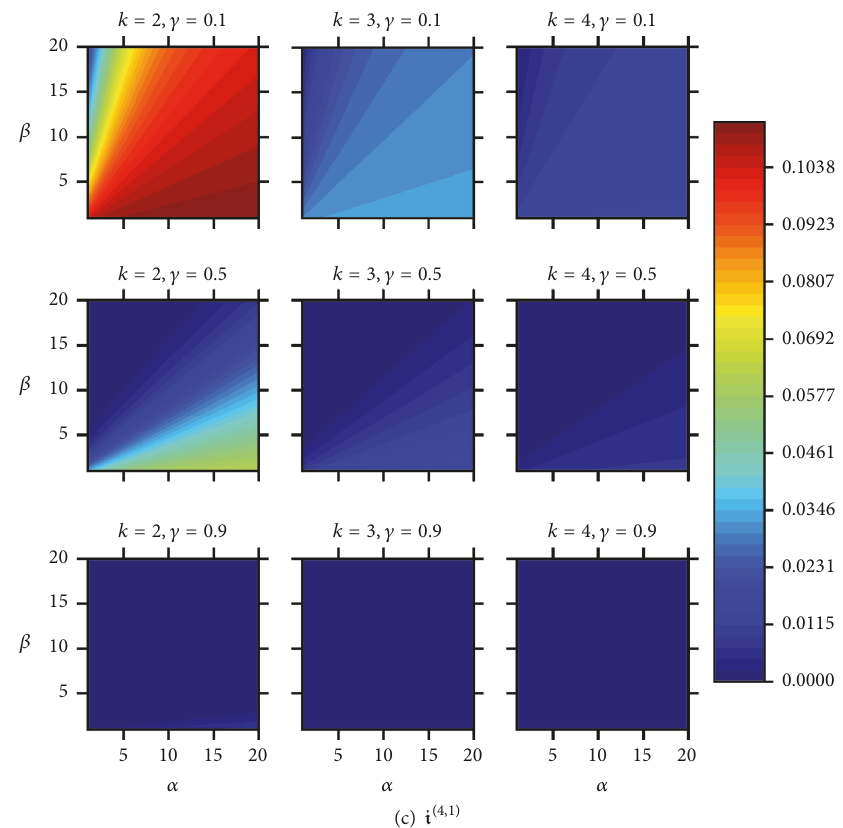
Figure 3: Impact ratios for varying supplier distance, 𝐿 𝑖𝑗 , beta distribution parameters 𝛼 and 𝛽 , branching ratio 𝑘 , and resilience fraction 𝛾 .